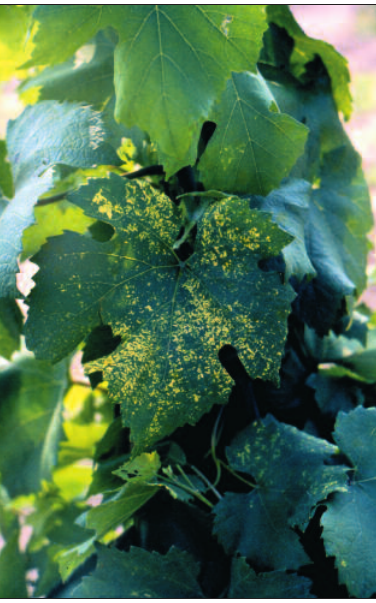
Figure 16. Yelow mottle (AMV) – yellow discolorations of the foliage in the form of speckling, blotches, rings and lines